Question: Author a descriptive caption for the visualization shown.
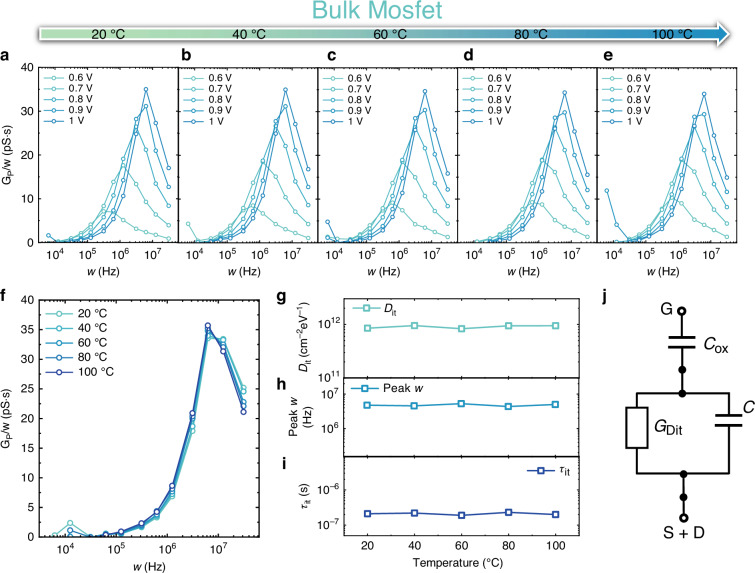
Answer: Temperature-dependent conductance analysis of the bulk MOSFET using the conductance method. a – e G p / ω measured at different V G s for temperatures ranging from 20 to 100 °C. f Comparison of G p / ω at different temperatures, showing similar peak positions and magnitudes. g – i Temperature dependence of the extracted interface trap density D it , peak angular frequency, and effective trap time constant. j Equivalent circuit used for the conductance analysis, consisting of the capacitance C and the interface trap conductance G Dit